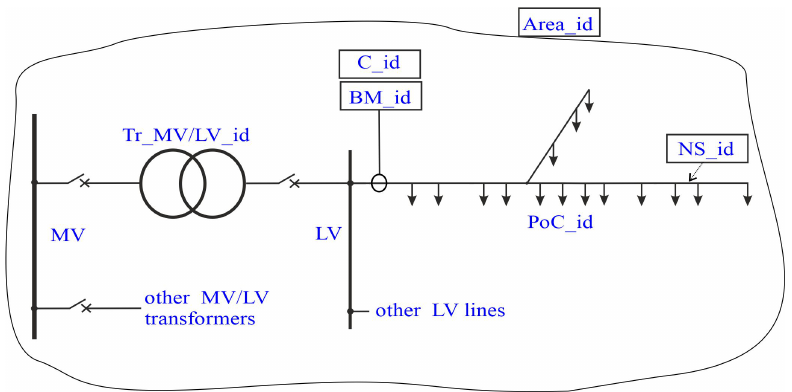
Figure 1. The analyzed simplified network structure with installed balancing meters (BM) and customer meters (PoC) (the designations are described in the